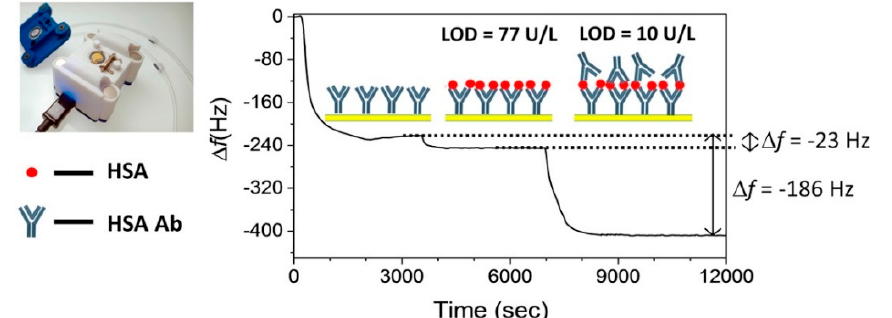
Figure 5. QCM-based biosensor for human salivary α -amylase determination. The immobilization of the various components and targets on the QCM surface is accompanied by characteristic shifts in frequency that are quantified by the readout system. Reprinted with permission from ref. [131]. Copyright 2017 Elsevier.